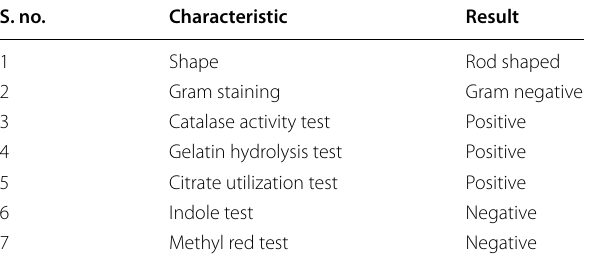
Table 6 Morphological and biochemical confirmatory tests for P. aeruginosa